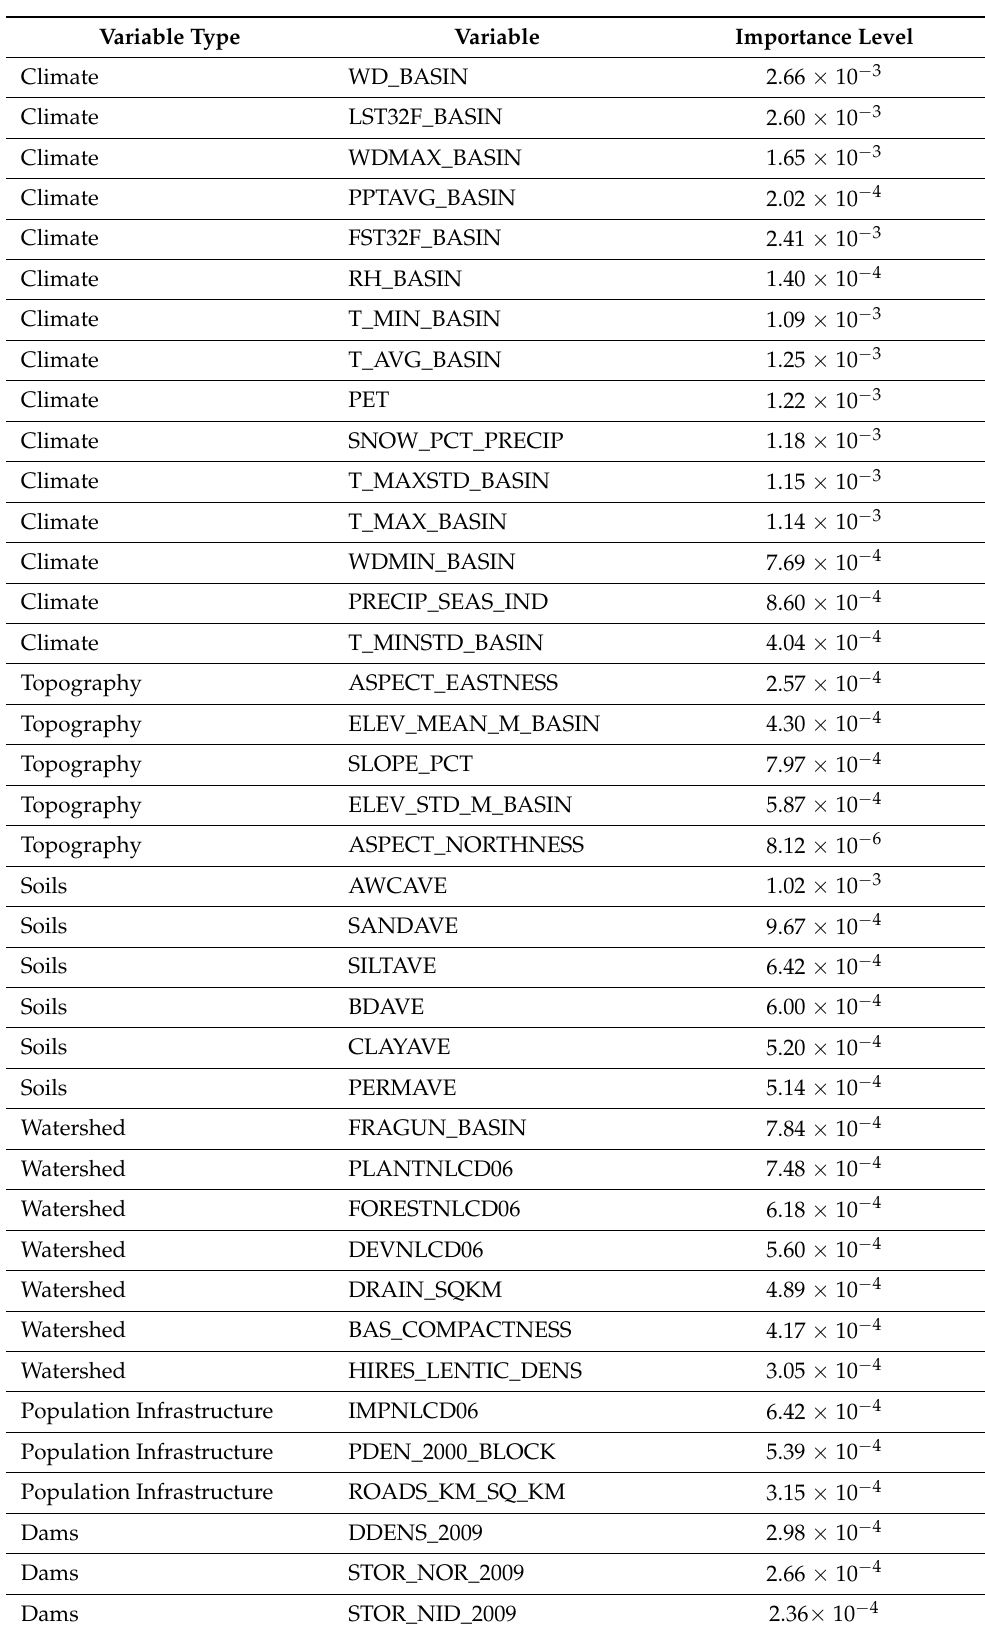
Table A6. Predictor variables retrieved for all sites